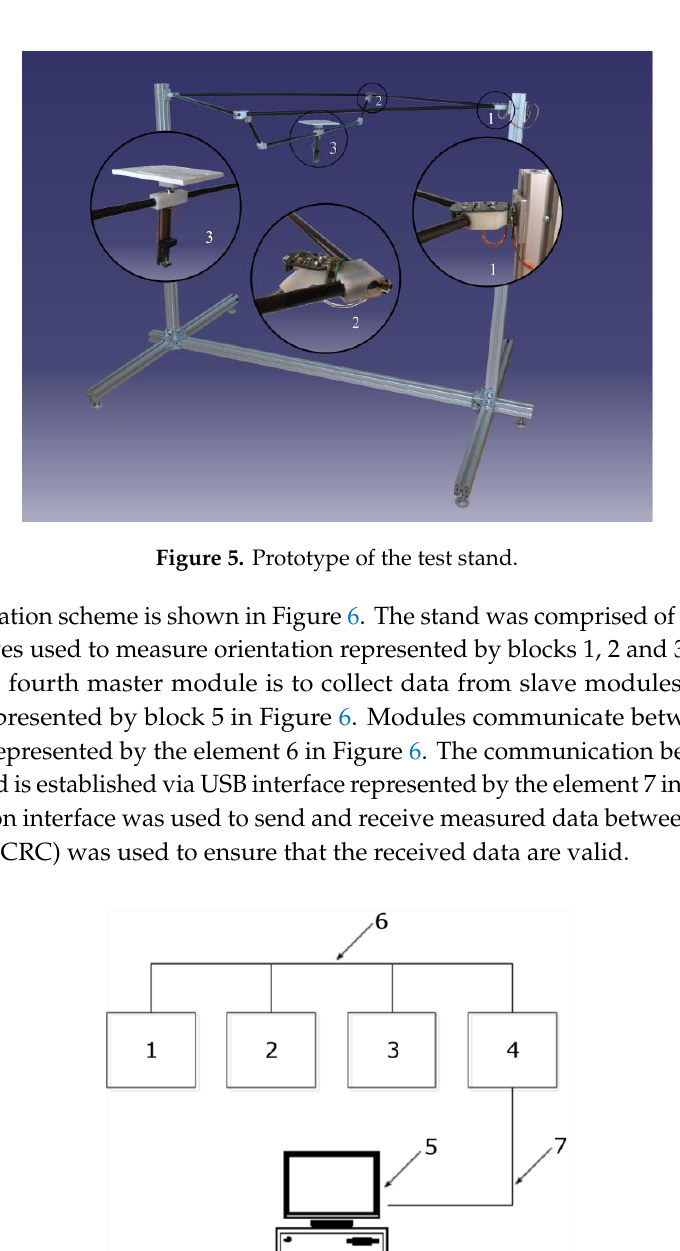
Figure 4. Design of test stand made in CAD software.